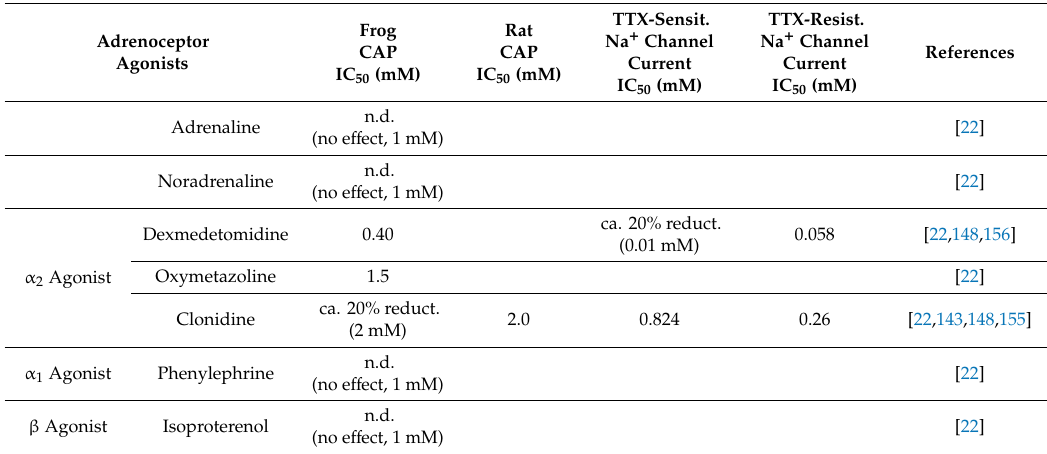
Table 3. Comparison of IC 50 values in inhibiting frog or rat sciatic nerve fast-conducting CAPs and TTX-sensitive or -resistant Na + channels among adrenoceptor